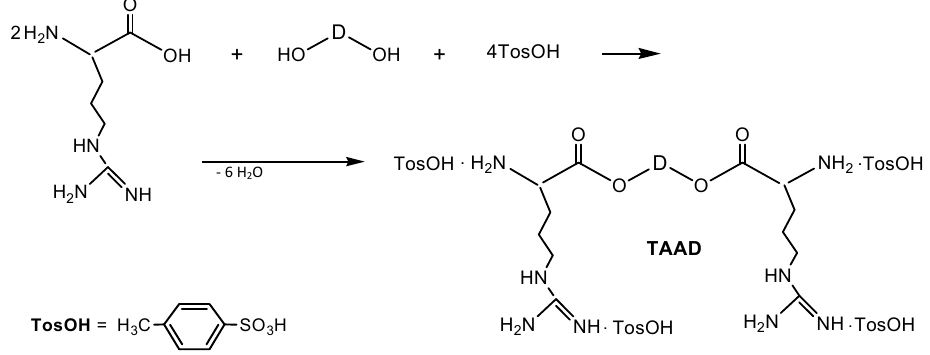
) with x = 2, 3, 6, 12 or 2 x